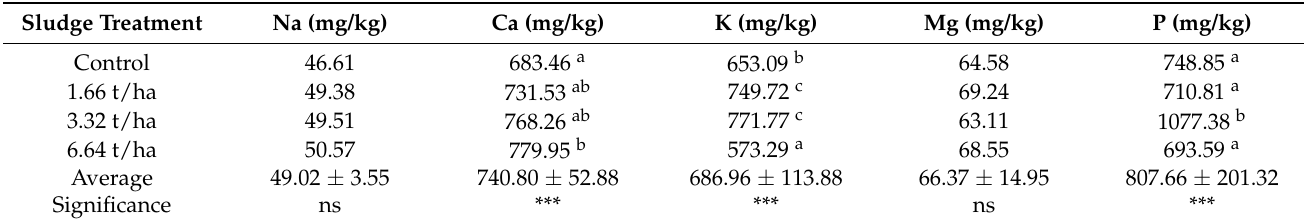
Table 7. Macro element content of Miscanthus biomass fertilized with municipal sewage sludge.